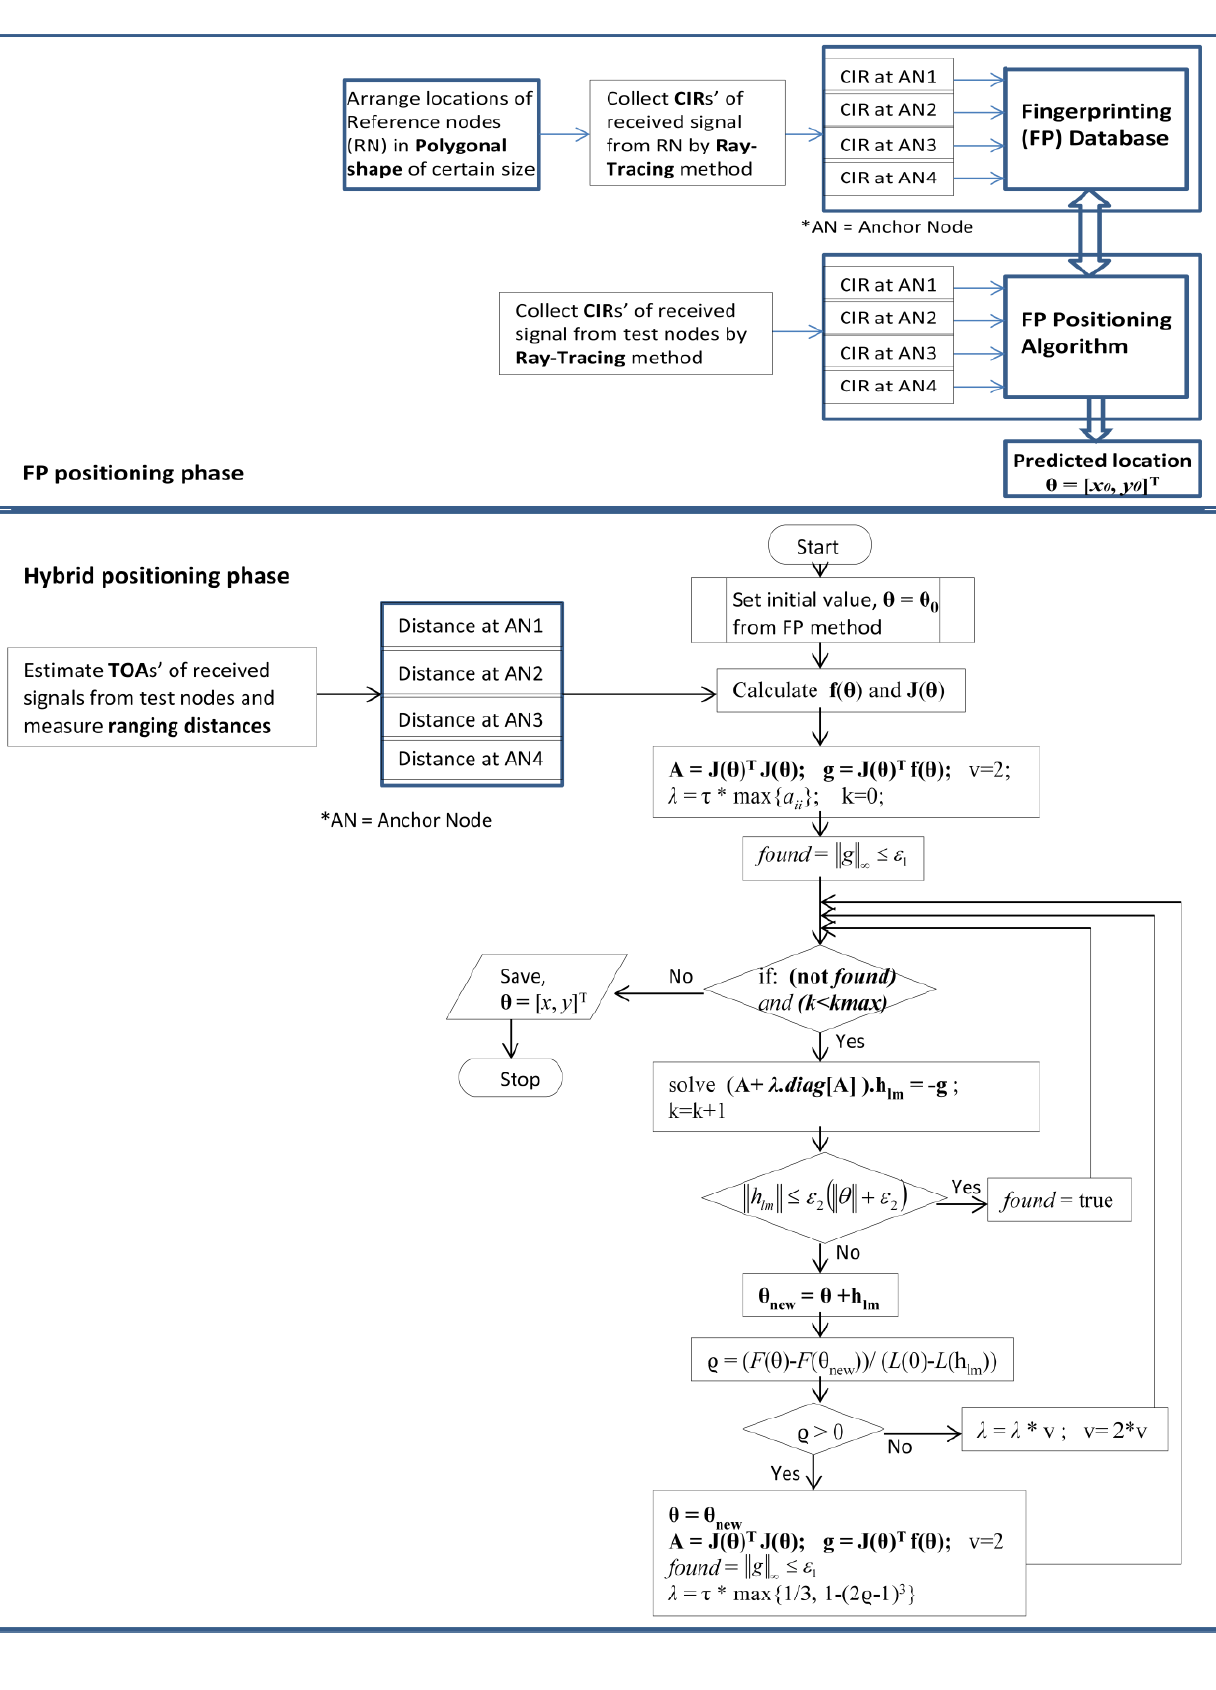
Figure 5. Flow chart for the proposed positioning